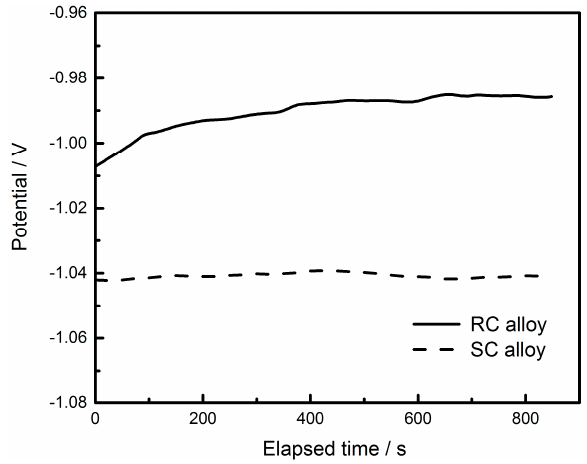
Figure 3. Open circuit potential curves for Sn–8Zn–3Bi solder alloy.